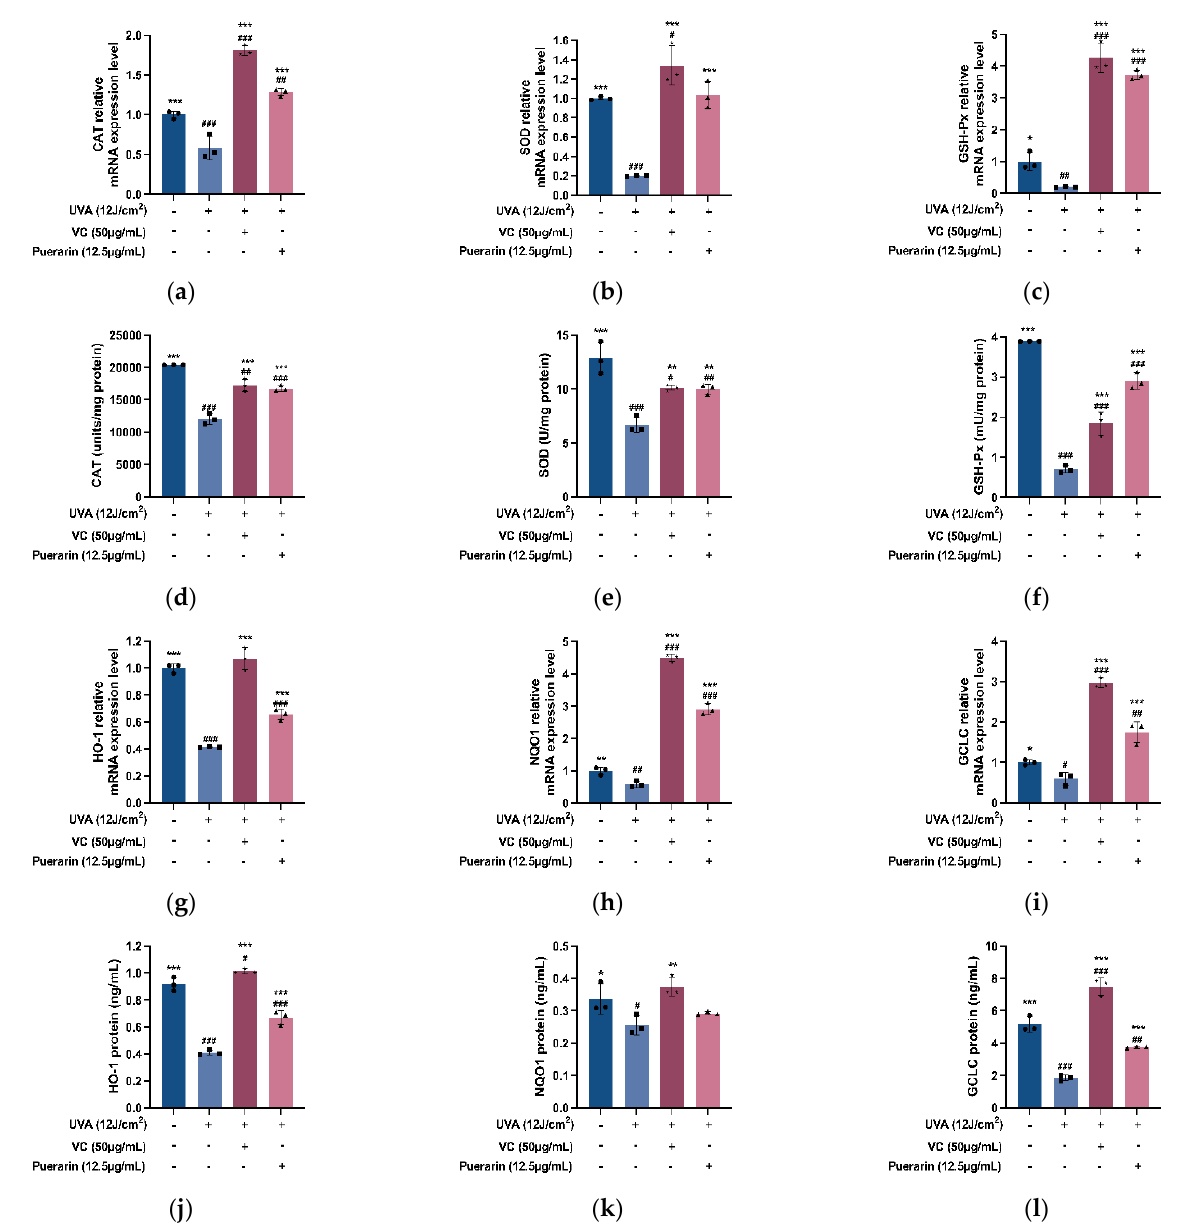
Figure 4. Effects of puerarin on UVA ‐ induced antioxidase in HSF: ( d – f ) RT ‐ PCR analysis of puerarin on UVA ‐ induced SOD, CAT, and GSH ‐ Px expression in HSF; ( a – c ) ELISA analysis of puerarin on UVA ‐ induced SOD, CAT, and GSH ‐ Px; ( j – l ) RT ‐ PCR analysis of puerarin on UVA ‐ induced HO ‐ 1, NQO1, and GCLC expression in HSF; ( g – i ) ELISA analysis of puerarin on UVA ‐ induced HO ‐ 1, NQO1, and GCLC. # p < 0.0 5 , ## p < 0.0 1 , ### p < 0.001 as compared to the control group; * p < 0.05, ** p < 0.01, *** p < 0.001 as compared to the damage model group; Values do not have a common mark ( # , *) when p > 0.05, ( n = 3).